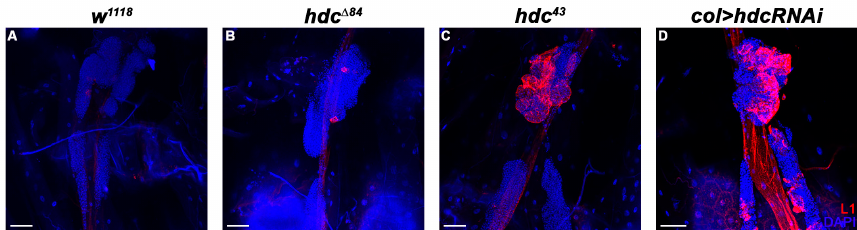
Figure 3. Lamellocyte differentiation in the lymph gland of hdc mutant and hdc silenced larvae. ( A ) There are no lamellocytes present in the lymph gland of w 1118 control larvae; ( B – C ) Lamellocytes are detected with staining for the L1 marker (red) in the lymph gland of hdc ∆ 84 ( B ) and hdc 43 ( C ) larvae; ( D ) Silencing of hdc with the col-Gal4 driver ( Pcol85-Gal4, UAS-hdcRNAi/+ ) also resulted in the differentiation of lamellocytes (red) in the lymph gland. Nuclei were stained with DAPI (blue). Confocal images were generated with a Leica TCS SP5 Confocal Microscope, original magnification × 20, and processed with LAS AF Lite (Leica Microsystems CMS GmbH), ImageJ and Adobe Photoshop CS2 softwares. Scale bars: 50 µm.